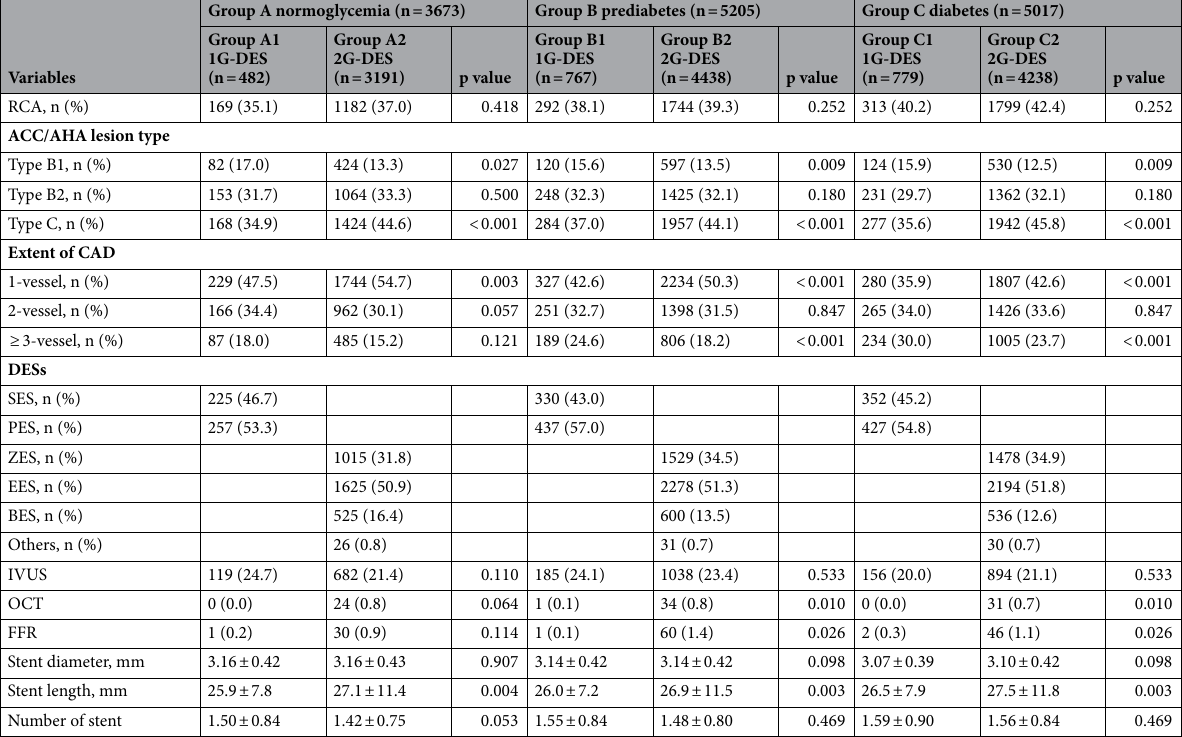
Table 1. Baseline clinical, laboratory, and procedural characteristics. Values are means ± SD or numbers and percentages. The p values for continuous data were obtained from the analysis of variance. The p values for categorical data were obtained from the chi-square or Fisher’s exact test. PCI percutaneous coronary intervention, BMS bare-metal stents, 1G first-generation, 2G second-generation, DES drug-eluting stents,